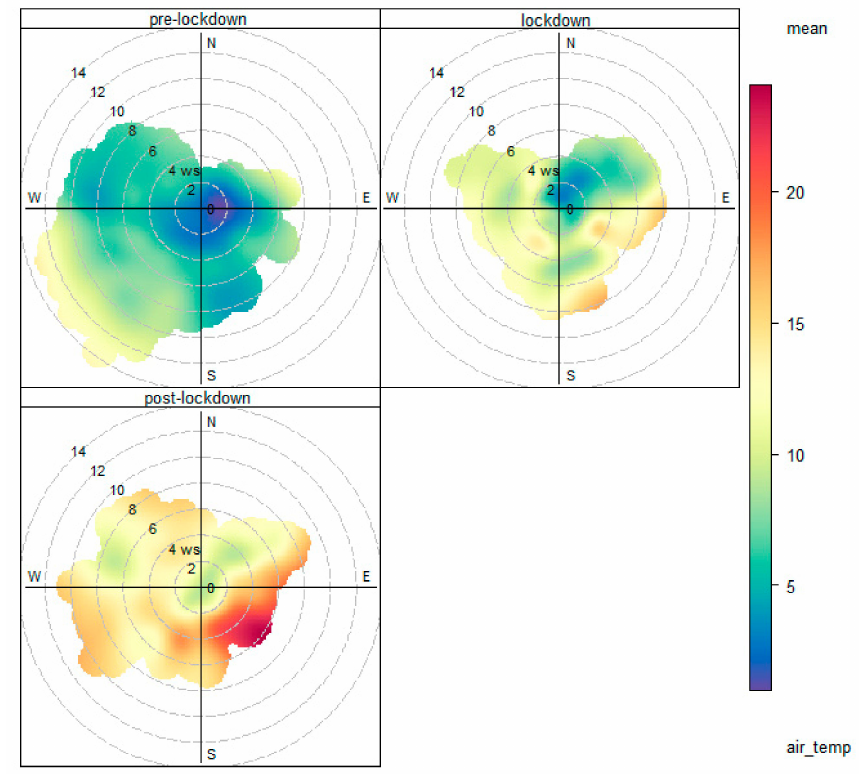
Figure 2. Polar plots of wind speed, wind direction and temperature at Manchester Piccadilly AQMS during pre-lockdown, lockdown, and post-lockdown period,